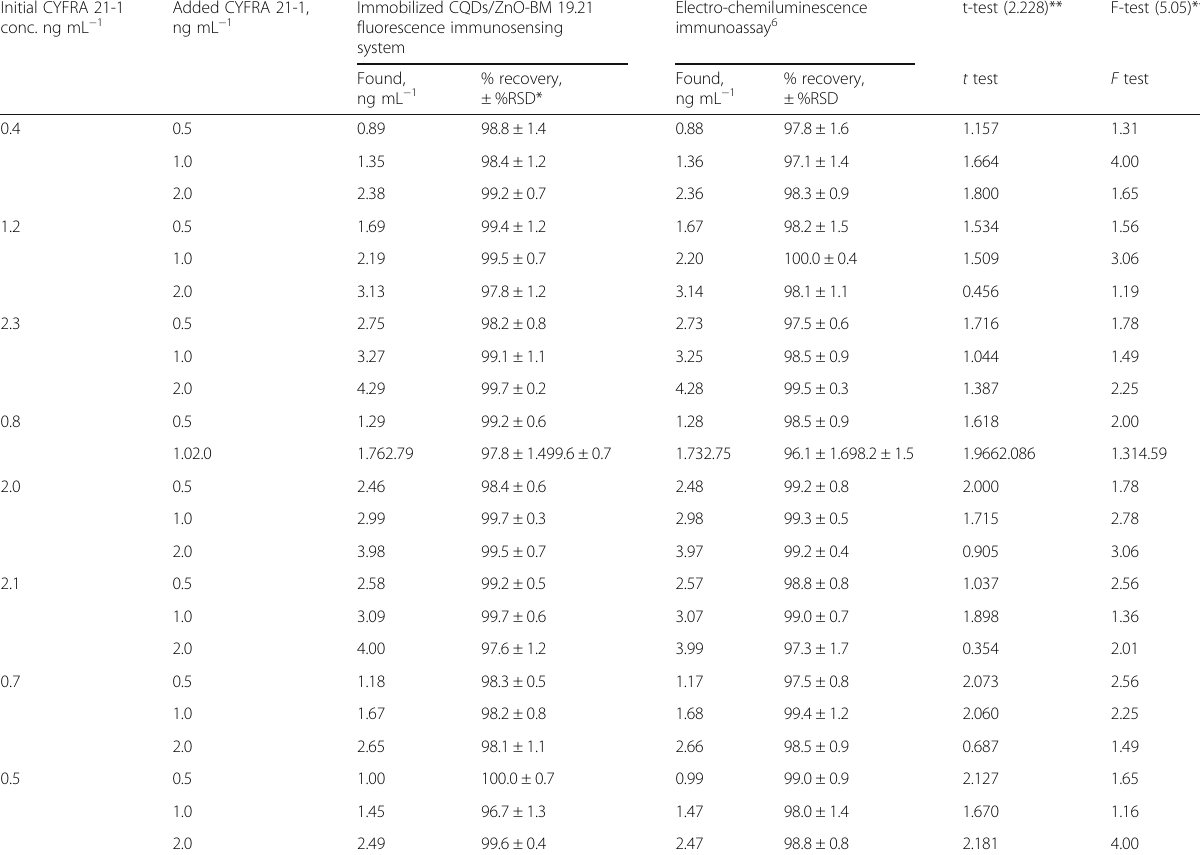
Table 4 Comparative results obtained by the suggested Immobilized CQDs/ZnO-BM 19.21 fluorescence immunosensing system and published method